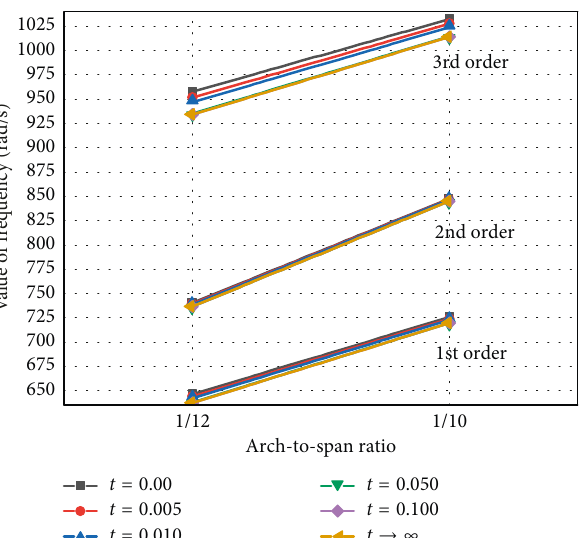
Figure 14: Frequencies (rad/s) with different arch-to-span ratios and time instants.